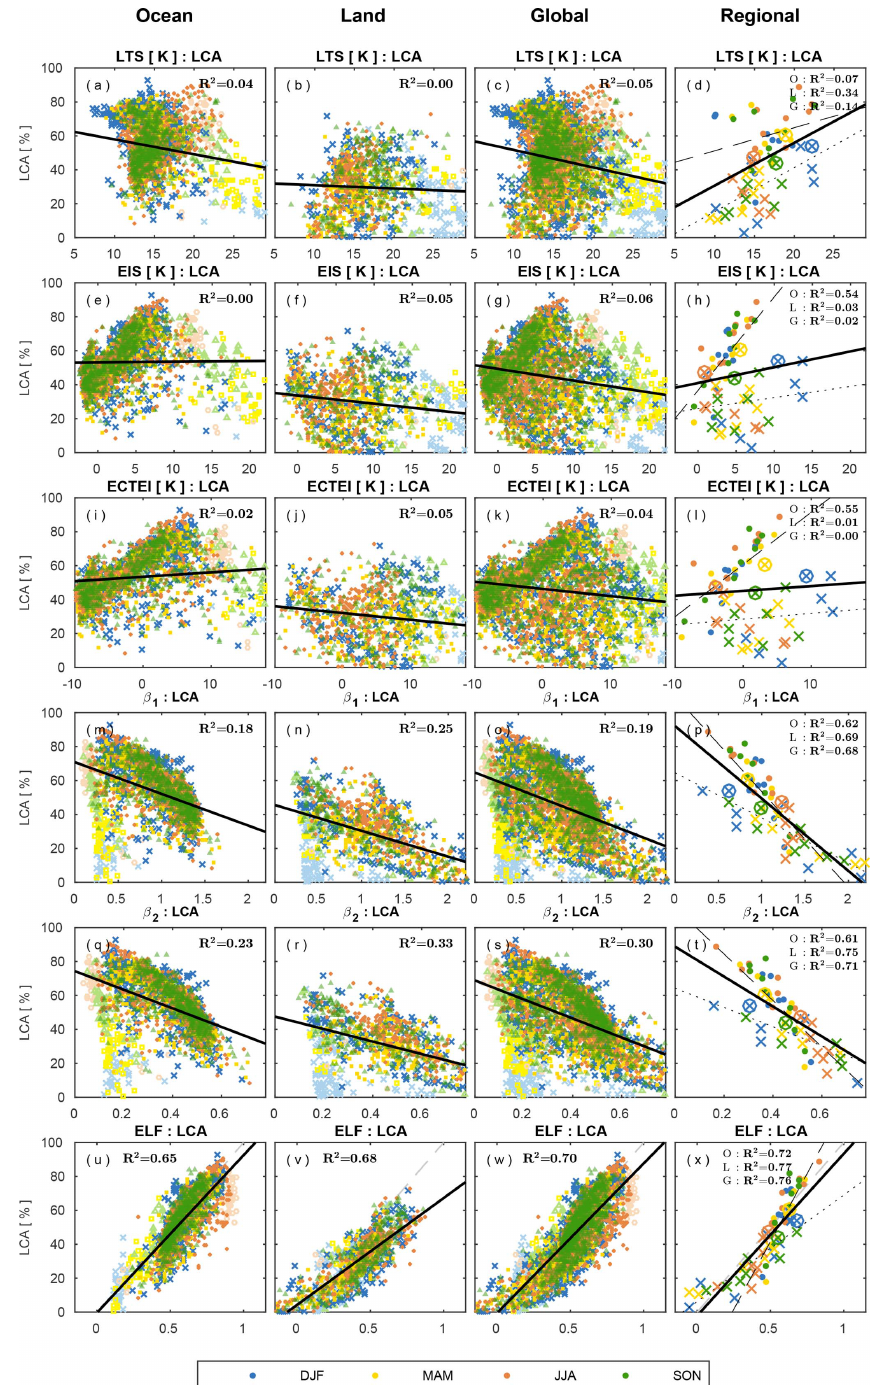
Figure 12. Scatter plots between LCA and six proxies over the (first column) ocean, (second) land, (third) globe, and (fourth) selected regions shown in Fig. 7 with the least-squares fitting lines and the fraction of variance ( R 2 ) explained by the regression lines. The dashed gray line in the panels (u)–(x) denotes LCA = ELF. All observation data (i.e., 0 < α < 1, α = 0, and α = 1) are used for this figure. The grid data in the range of 0 ≤ α < 0 . 01 (i.e., very stable regime) are denoted by light colors in the first three